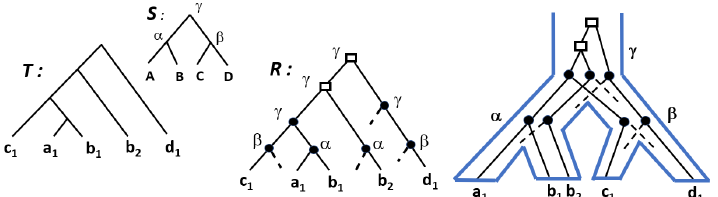
Figure 3. A gene tree T for the gene family Γ = { a 1 , b 1 , b 2 , c 1 , d 1 } , where a gene x i belongs to the genome X ; a species tree S for the genomes Σ = { A , B , C , D } ; a DL-reconciliation (cid:104) R , ˜ s , ˜ e (cid:105) of cost DL ( T , S ) , where ˜ s is represented by the letter and ˜ e by the label (rectangle or plain circle) assigned to each internal node of R . On the right, a representation of R embedded in the species tree S